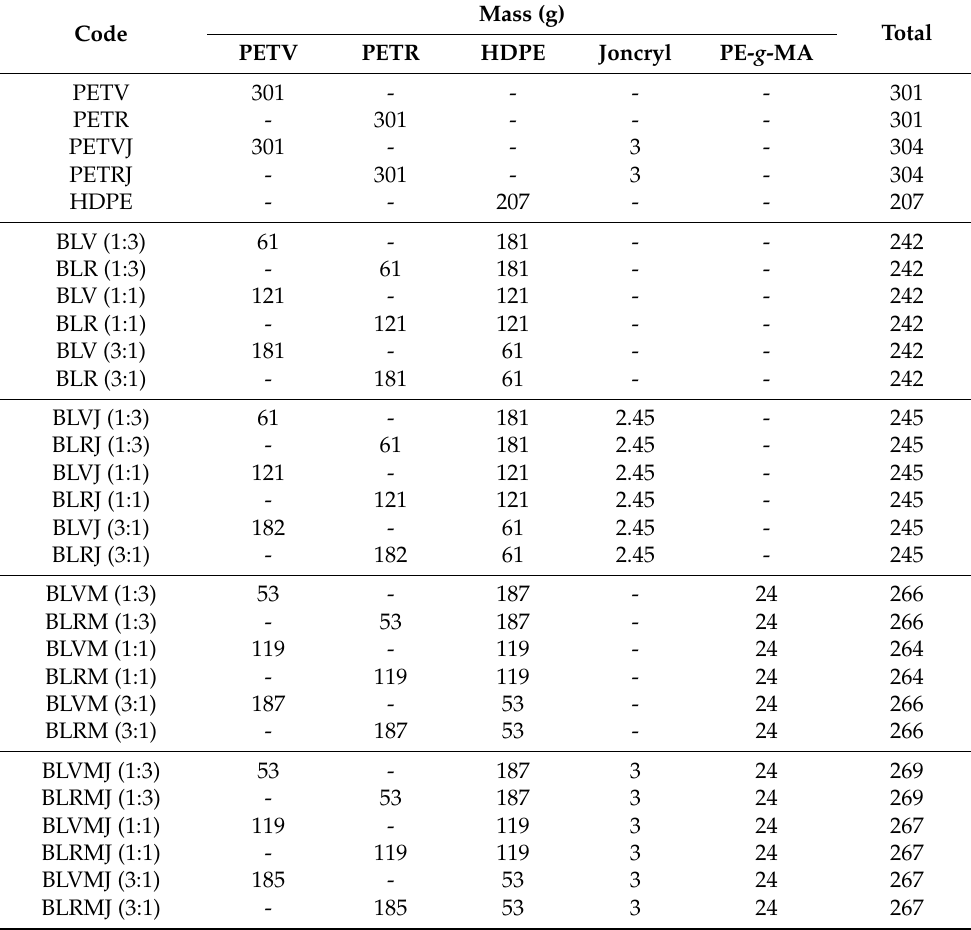
Table 1. Samples’ compositions and